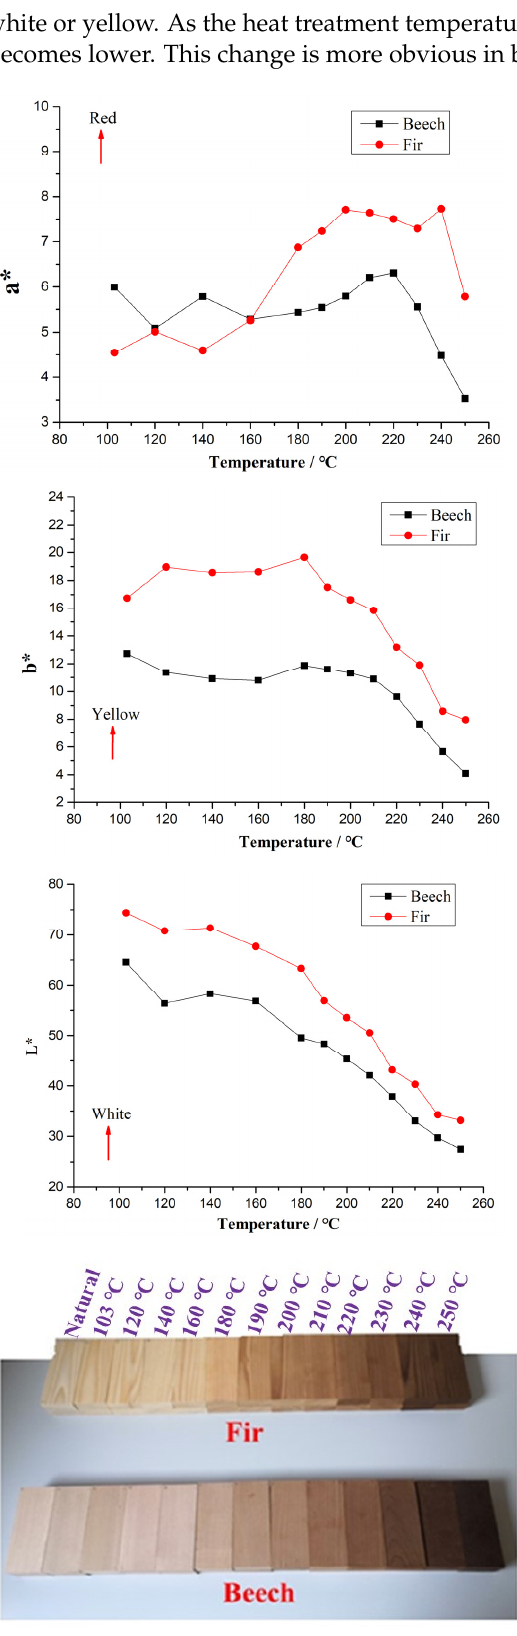
Figure 7. Color changes of color components a*, b* and L* as a function of treatment temperature and visual of color change of beech and fir specimens under treatment temperatures.